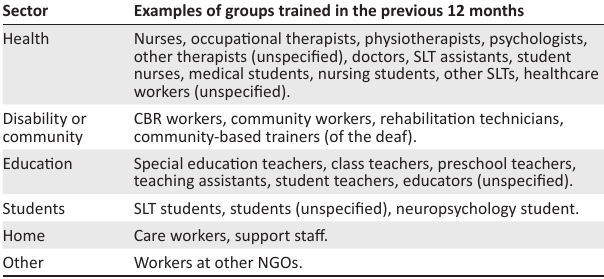
FIGURE 2: Proportion of time at work spent training others. TABLE 8: Examples of groups trained by speech and language therapists.